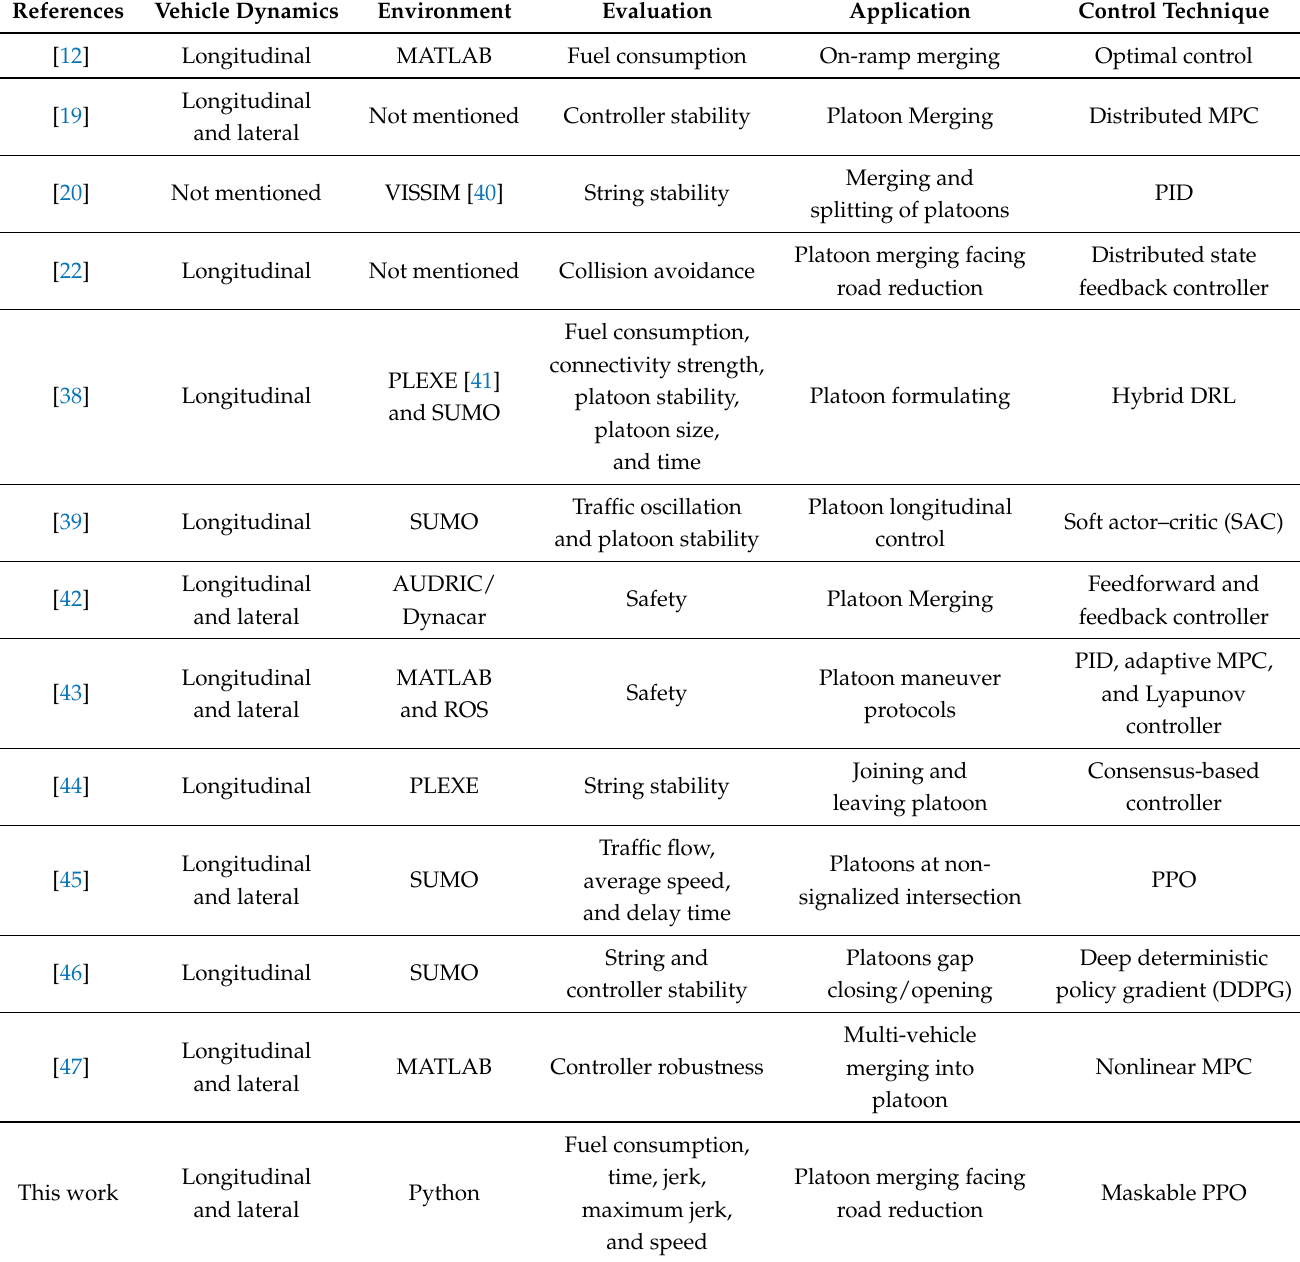
Table 1. State-of-the-art articles on platoon control